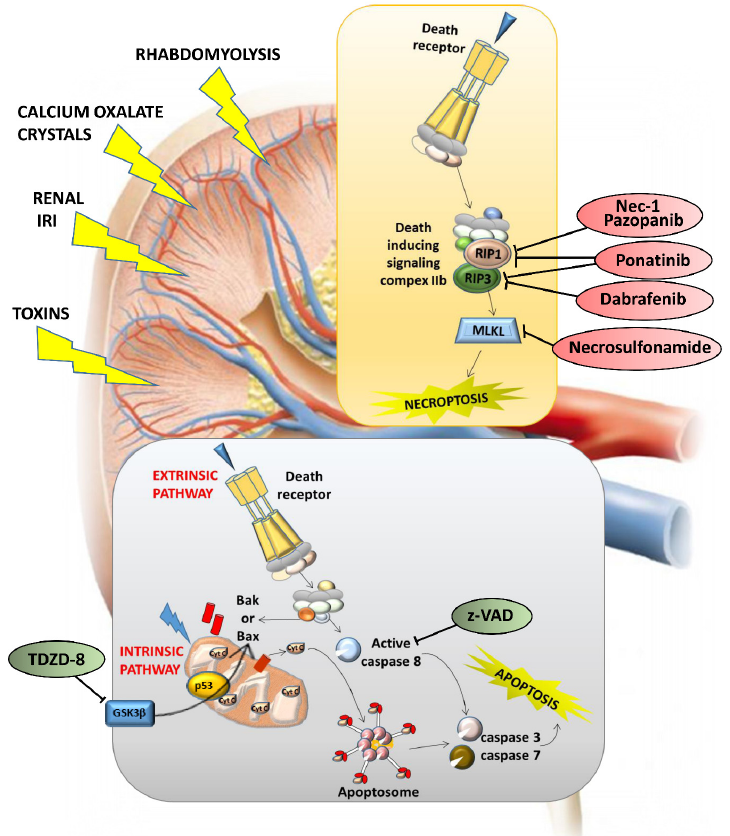
Figure 3. Targeting apoptosis and necroptosis in kidney lesions. Different kidney lesions activate different cell death modalities: z-VAD (z-Val-Ala-Asp fluoromethyl ketone) has been found to protect renal function, and the effect of the pan-caspase inhibitor z-VAD on experimental renal ischemia-reperfusion (I/R) injury was to reduce serum urea levels, thereby preventing inflammation. TDZD-8 (4-benzyl-2-methyl-1,2,4-thiadiazolidine-3,5-dione) has been found to inhibit ischemia-induced activation of GSK3 β (glycogen synthase kinase 3 beta), Bax, and caspase 3, thus ameliorating tubular and epithelial cell damage and significantly protecting renal function.